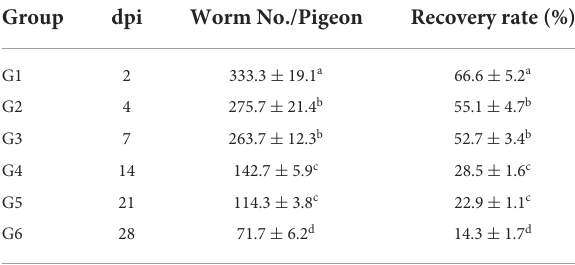
TABLE 2 Worm recovery from experimentally infected pigeons at different time